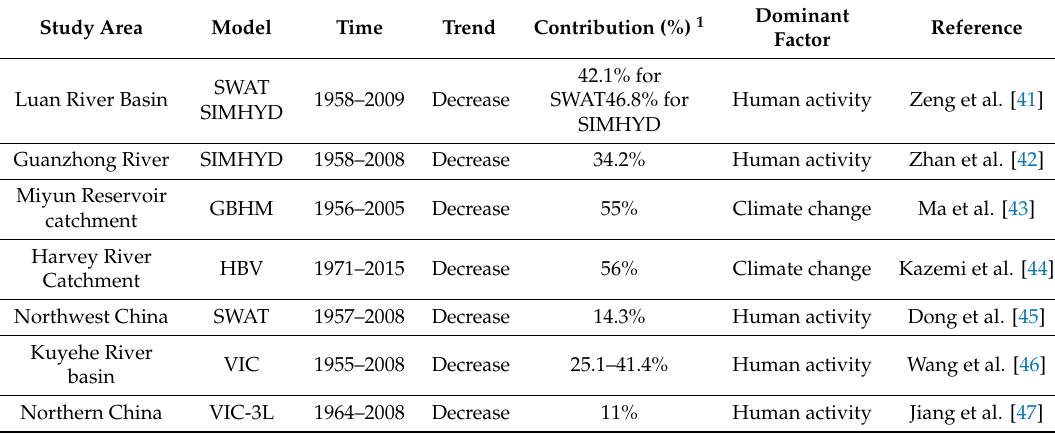
Table 1. Hydrological models and scenario combinations for research on the impact of climate change and human activities on runo ff